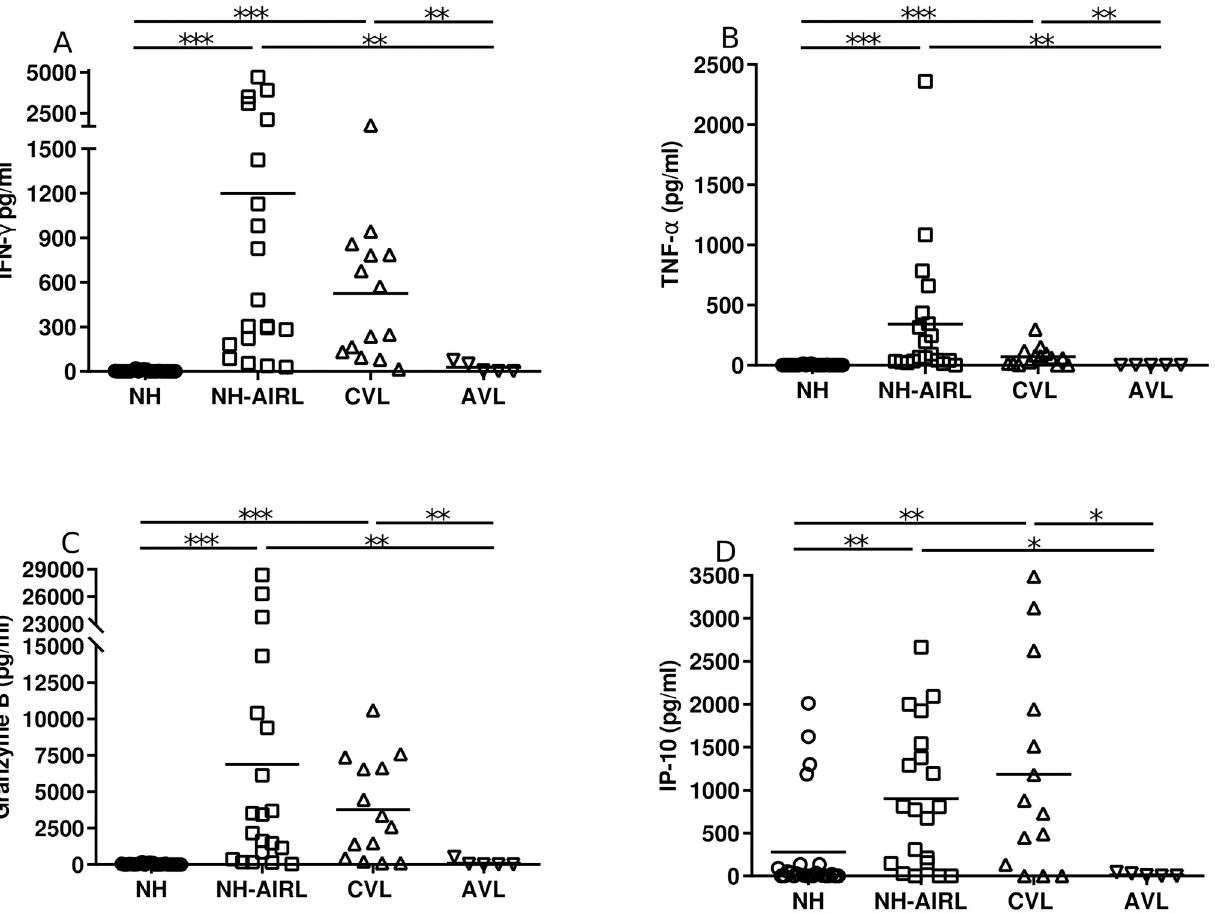
Fig 2. Production of a) IFN- γ , b) TNF- α , c) granzyme B and d) IP-10 in supernatants of PBMC cultures stimulated with SLA. NC normal controls, NH-AIRL asymptomatic immune responders to Leishmania , CVL patients cured of leishmaniasis, and AVL patients with active VL. � p < 0.050, �� p < 0.010, ��� p <